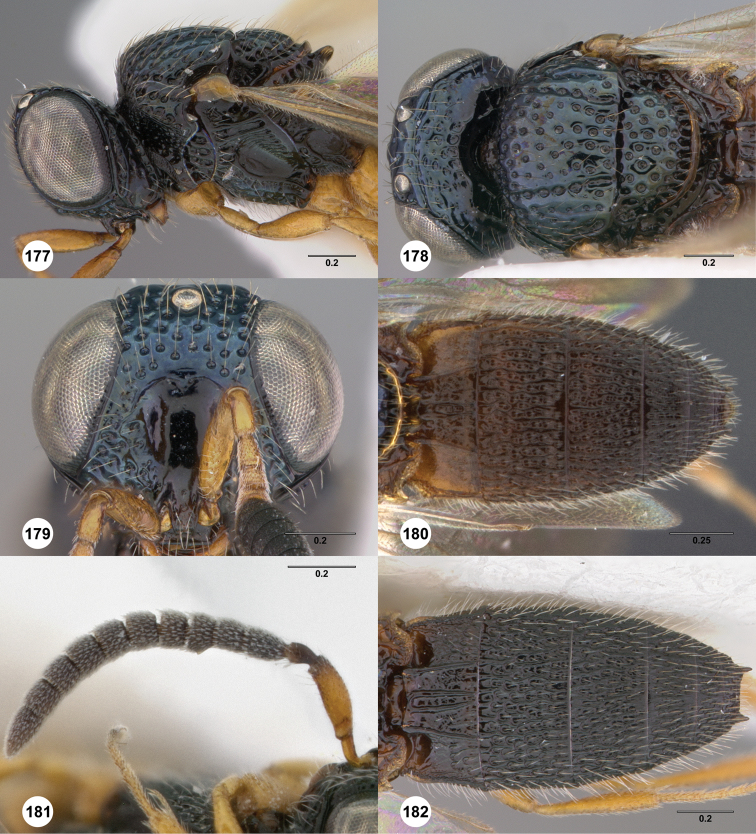
Oxyscelio livens sp. n., holotype female (OSUC 148485) 177 Head and mesosoma, lateral view 178 Head and mesosoma, dorsal view 179 Head, anterior view 180 Metasoma, dorsal view. Paratype male (OSUC 439598) 181 Antenna 182 Metasoma, dorsal view. Morphbank62